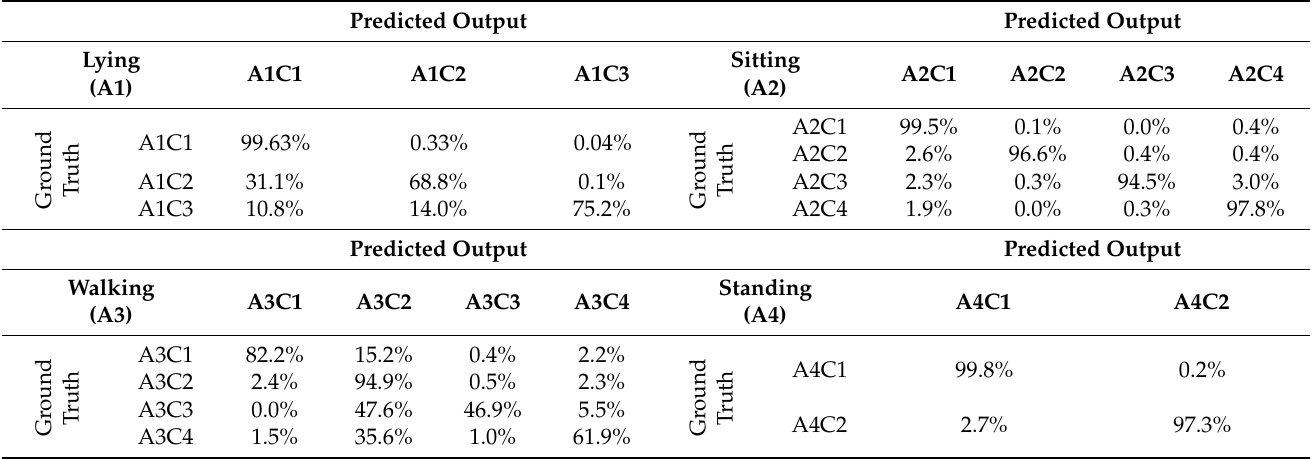
Table 6. Confusion matrices obtained for BCR with respect to four physical activities using BDT